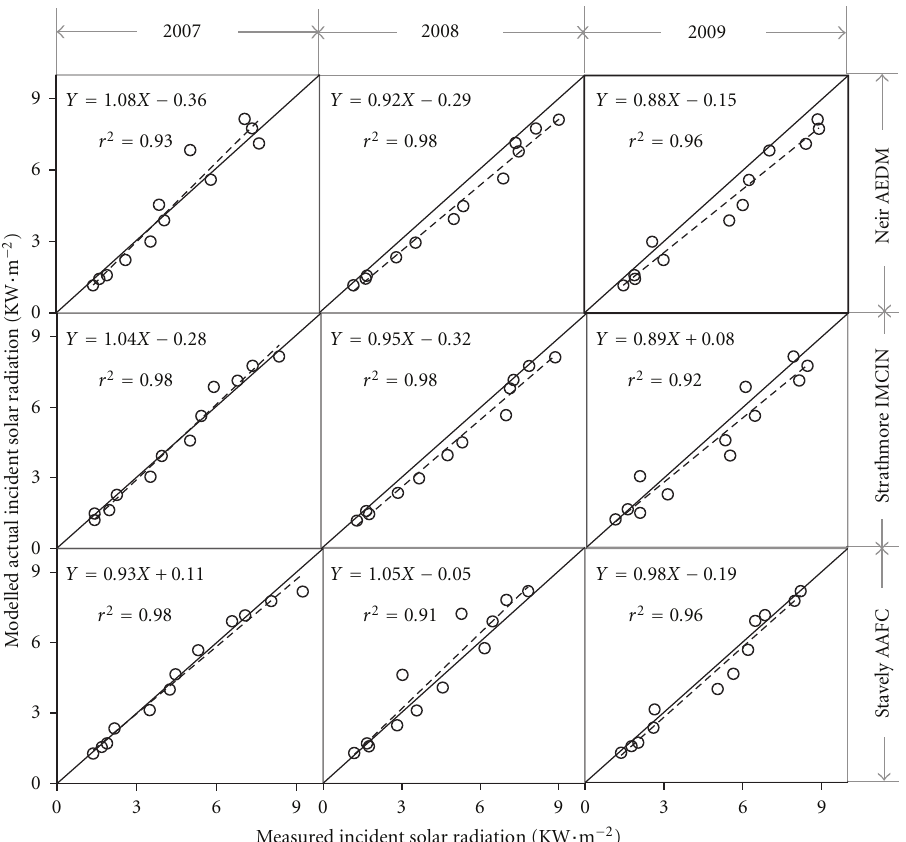
Figure 5: Relationships between measured and modelled values of the actual incident solar radiation accumulated at monthly scale at the locations of Neir AEDM, Strathmore IMCIN, and Stavely AAFC for the period of 2007–2009. The solid and dash lines represent the position of 1 :1 and linear regression lines, respectively.